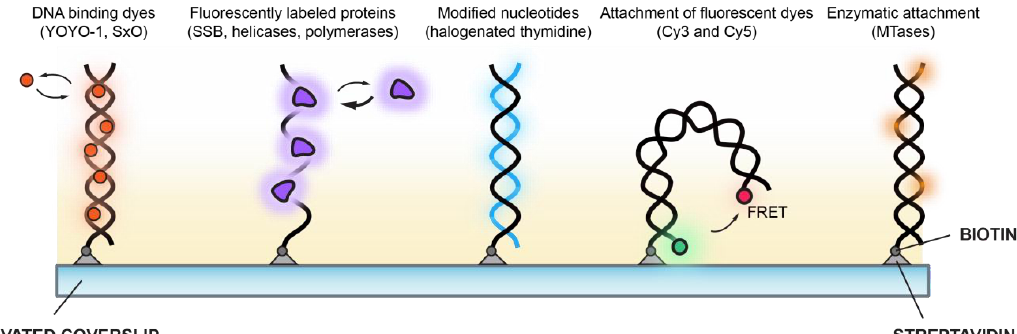
Figure 1. Visualising DNA molecules using electron microscopy. An electron micrograph generated by shadow-casting electron microscopy of multiple DNA polymerase proteins bound to individual DNA molecules (reproduced with permission from [11]).